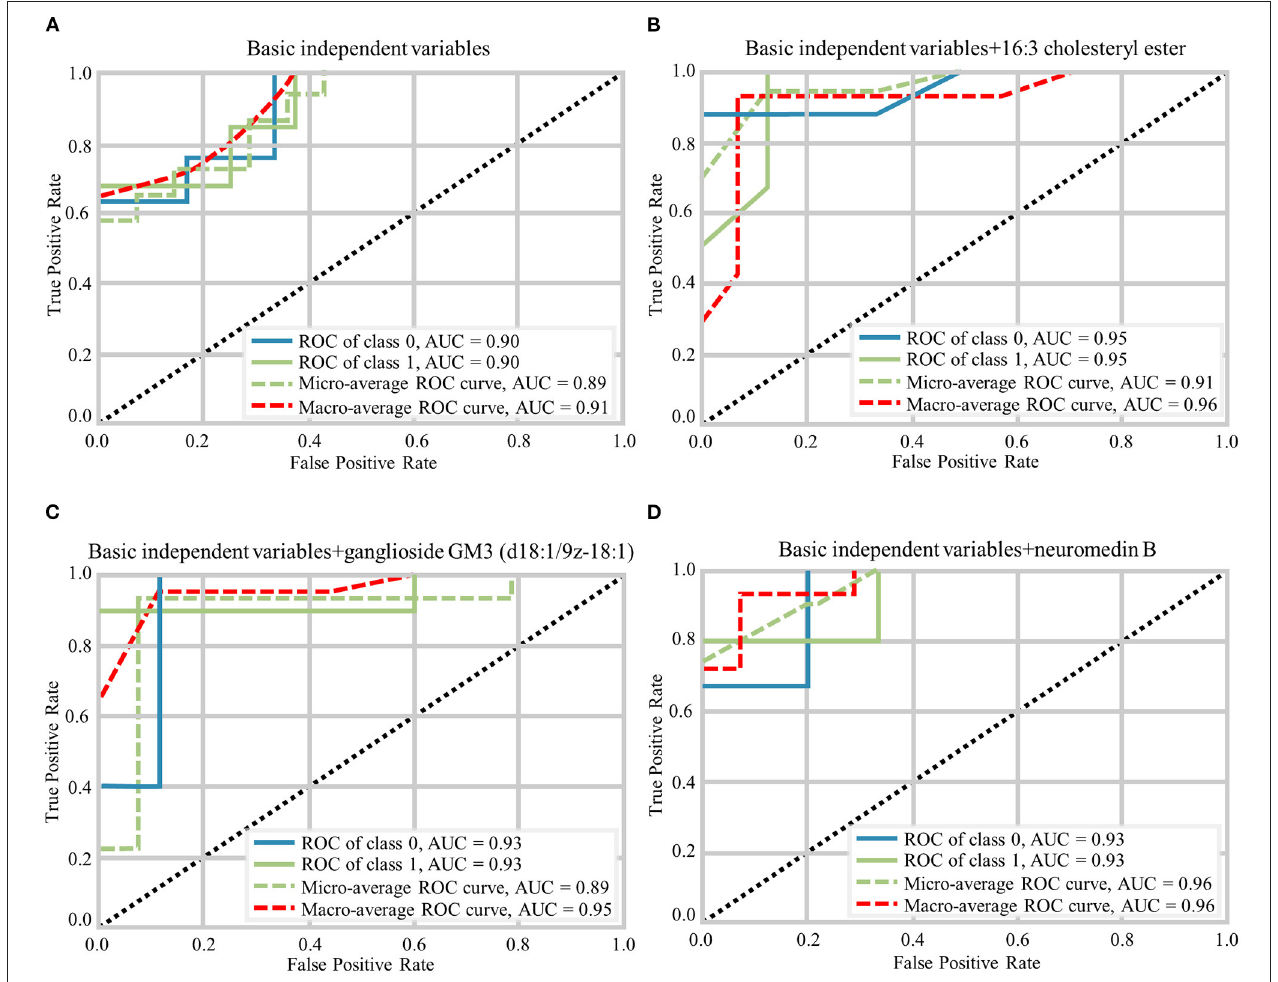
FIGURE 5 | Different prediction models generated by Random Forest Classifier and the macro-average ROC curve considered as a reference. (A) The ROC curves of basic independent variables. (B) The ROC curves of basic independent variables + 16:3 cholesteryl ester. (C) The ROC curves of basic independent variables + ganglioside GM3 (d18:1/9z-18:1). (D) The ROC curves of basic independent variables + neuromedin